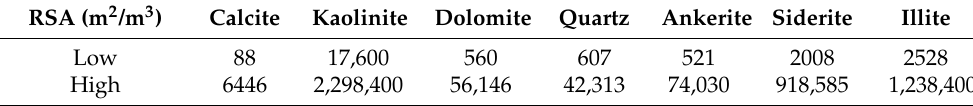
Table 1. Ranges of reactive surface area (RSA) of seven minerals from a literature survey [11,22–24,40,41]. RSA (m 2 /m 3 )